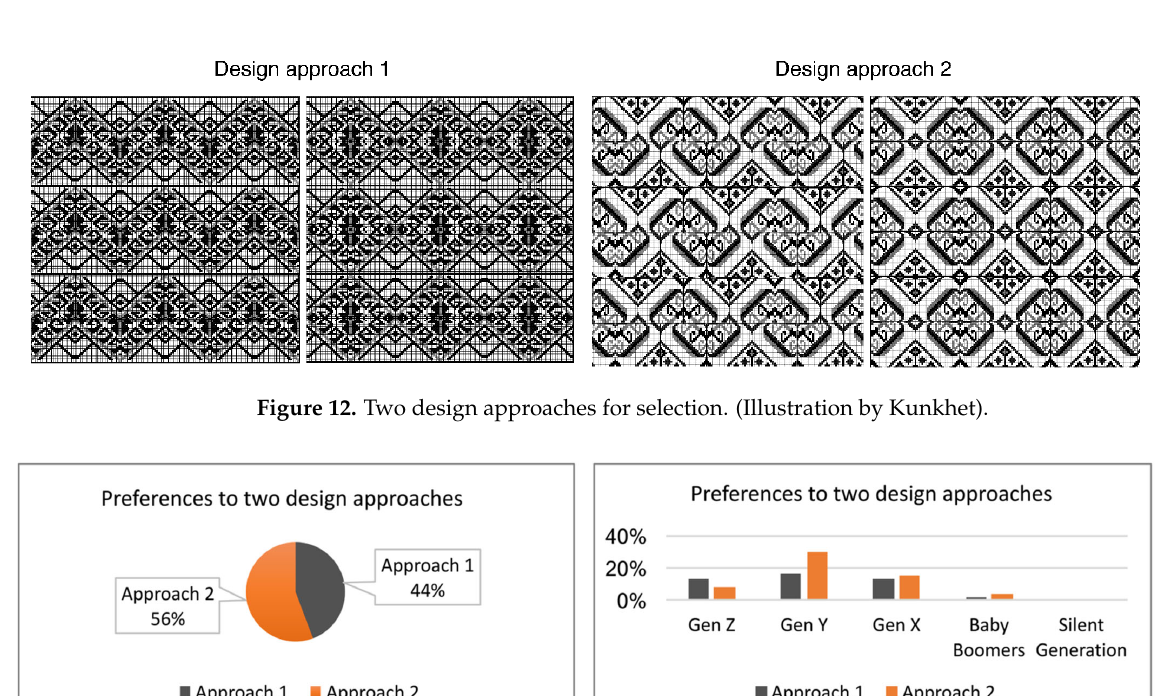
Figure 11. Numbers of respondents classified by generation, shown in percentage.